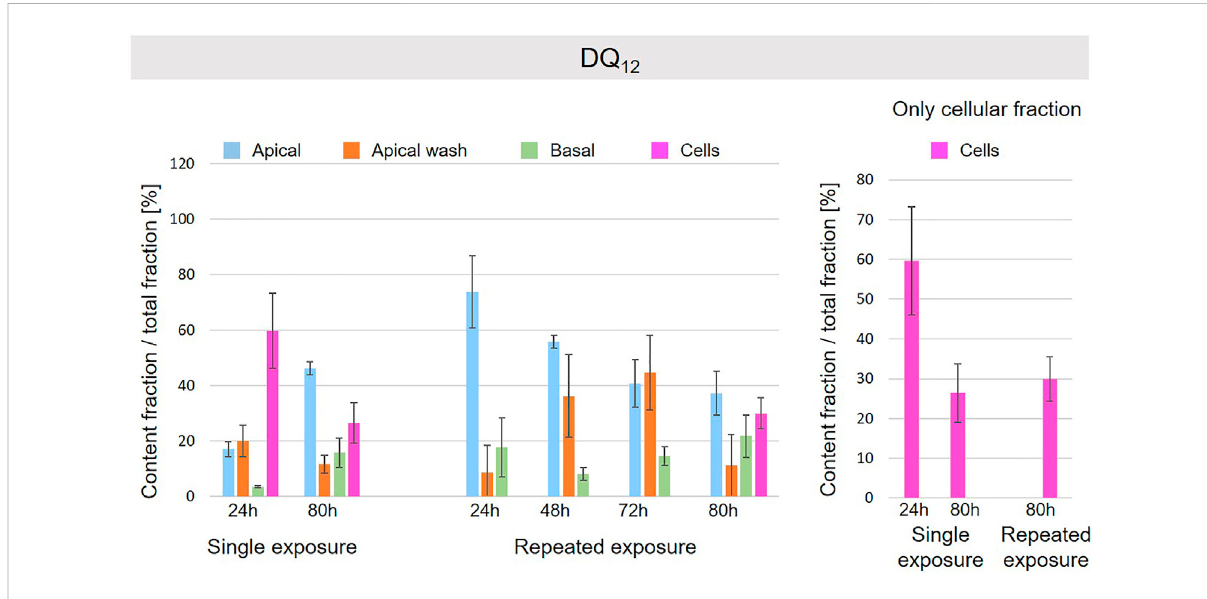
FIGURE 9 Fate of DQ 12 at the A549 tissue barrier after single and repeated exposures. For single exposures DQ 12 was exposed at a concentration of 100 µg/ml and the different fractions were collected after incubation for 24 and 80 h. For repeated exposures the cells were exposed repeatedly every day up to 80 h, using 25 µg/ml DQ 12 concentration, resulting in a total exposure of 100 µg/ml and 80 h incubation time in total. Apical, apical cellwashandbasalsampleswerecollectedafter24,48,72,and80 hofexposure.Rightside:Thisgraphonlydepictsthecellularfraction.Atotal of three independent experiments ( n = 3), with three single replicates each, were